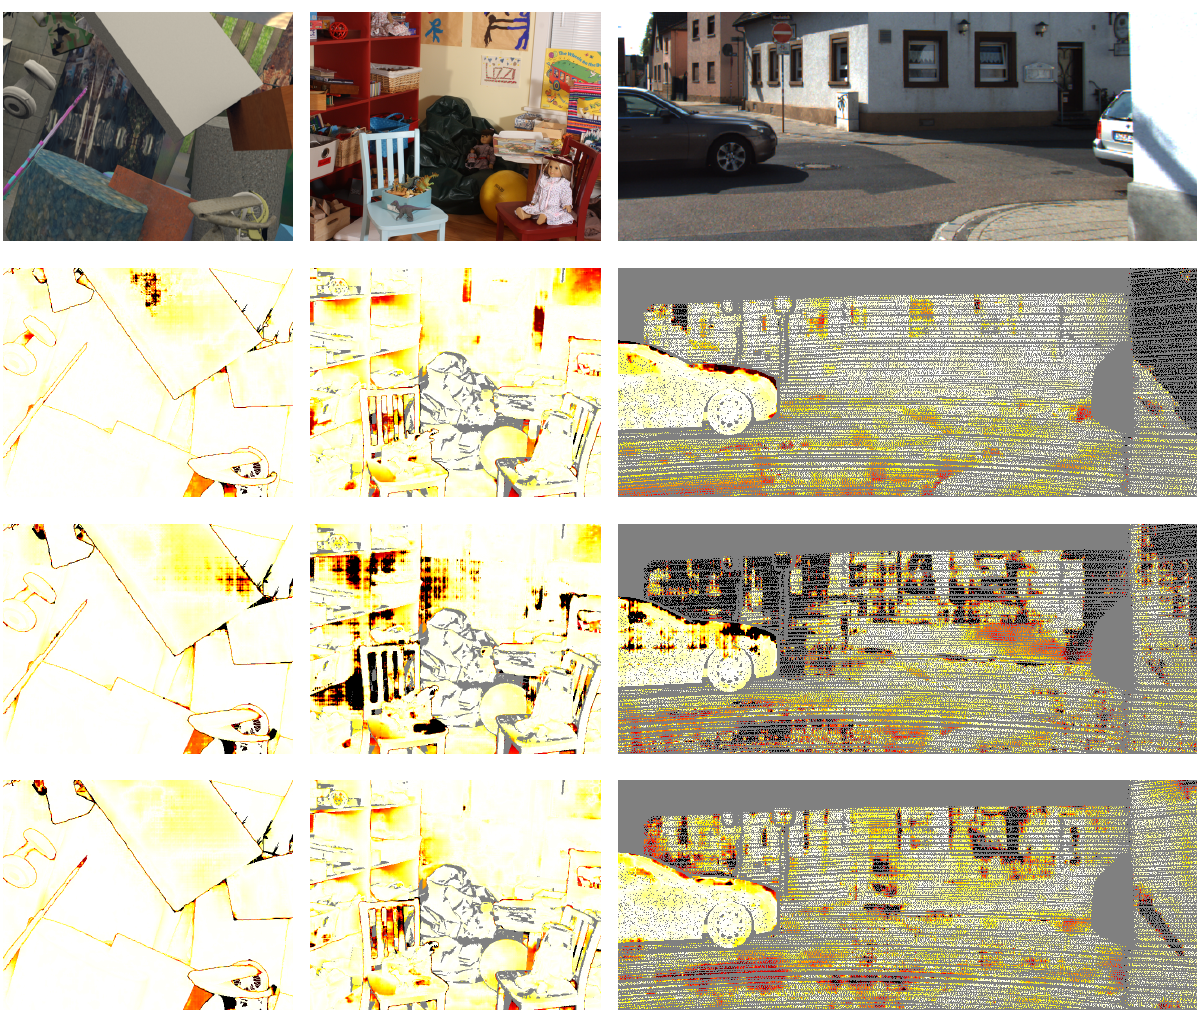
Figure 6: Qualitative depth evaluation. From left to right, one example from the Sceneflow FlyingThings3D, the Middlebury v3 and the KITTI 2015 dataset is shown. From top to bottom, the left reference image and the error maps for the original GC-Net (Kendall et al., 2017), GC-Net with aleatoric uncertainty (Kendall, 2017) and our probabilistic GC-Net, estimating aleatoric and epistemic uncertainty, are shown. The error maps encode a high error in black and a small one in white, while pixels without ground truth are displayed in grey. In general, it can seen that the original GC-Net architecture outperforms our probabilistic variant in areas with fine details, while the probabilistic architecture demonstrates superior performance in low textured